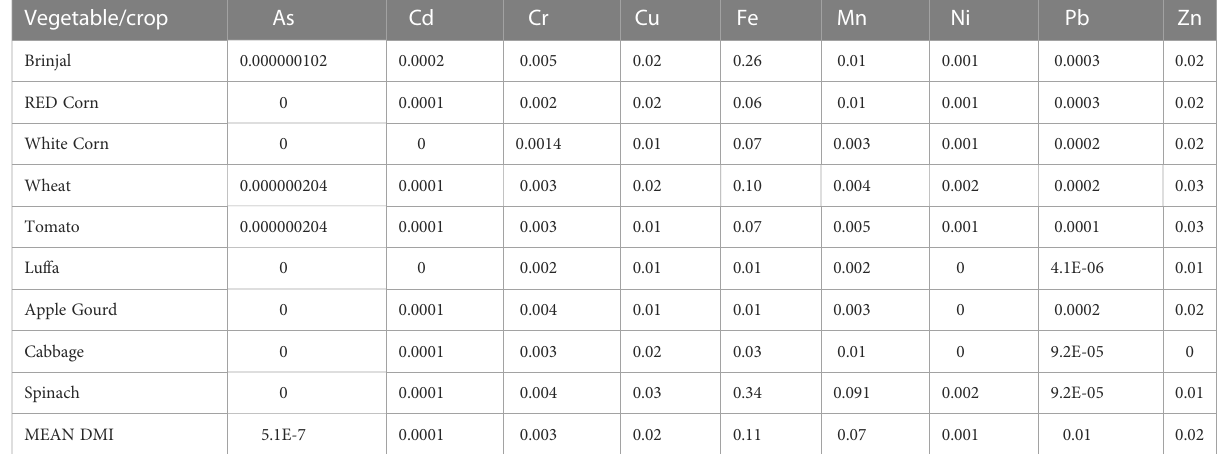
TABLE 4 Estimation of daily metal intake (mg person -1 day -1 ) through consumption of vegetable/crop food.